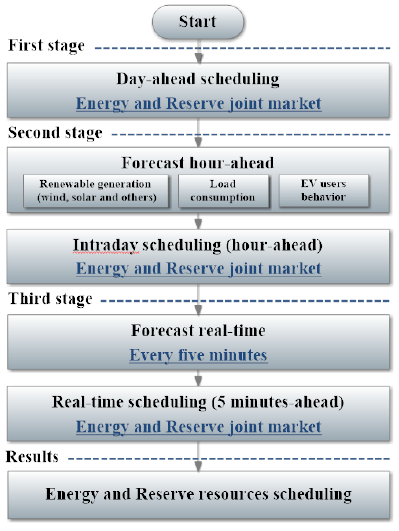
Figure 1. Timeline optimization of the proposed model.